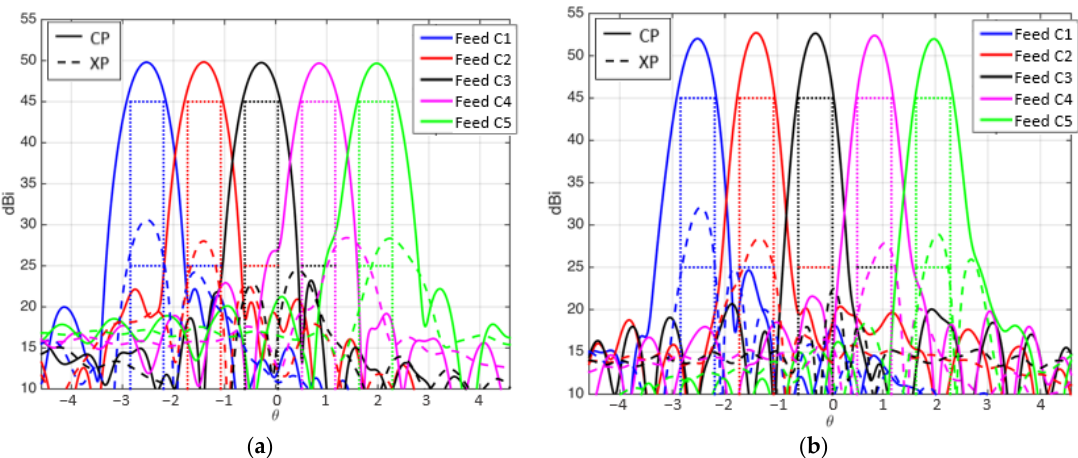
Figure 13. Simulated pattern contours for the 30 beams generated by 15 feeds illuminating the proposed dual reflectarray at 19.7 GHz and 29.5 GHz.